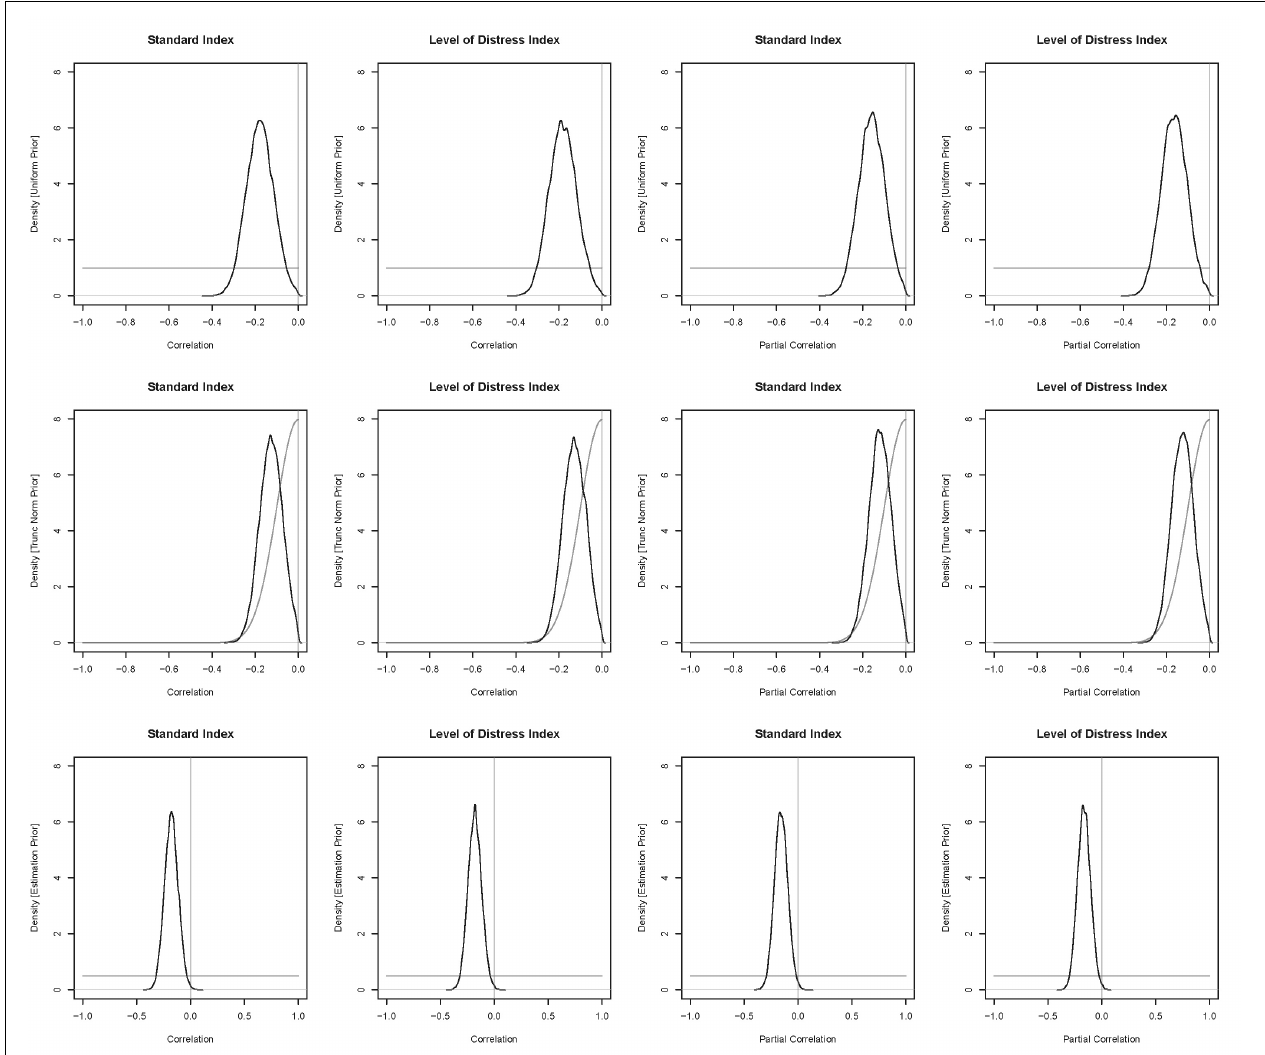
FIGURE 4 | Density of the posterior correlation distribution (black) and the prior distribution (dark gray) from our joint modeling analysis. Panels in the first row display the analyses with the uniform prior truncated at 0 (which follows the “default” priors used for Bayesian correlation analysis), panels in the second row display the analyses with the truncated normal prior, and panels in the third row display the analyses with the “estimation prior” (i.e., uniform with no truncated at 0). The first column displays the standard ELA index, and the second column displays the ELA index that accounts for the level of distress caused by the events. The third and fourth rows display the same respective indexes, though with the partial correlations that remove the variance attributed to SES. The light gray vertical line reflects the fixed point of 0, where the density of the posterior and the prior are compared to computed the Savage-Dickey ratio estimate of the